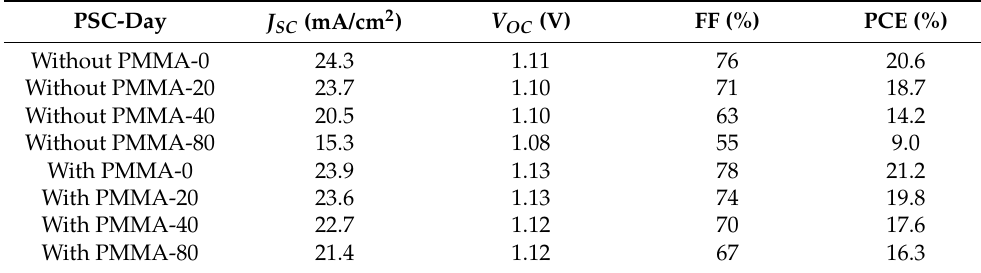
Table 1. Parameters of PSCs with and without PMMA-doped spiro-OMeTAD in the air environment.